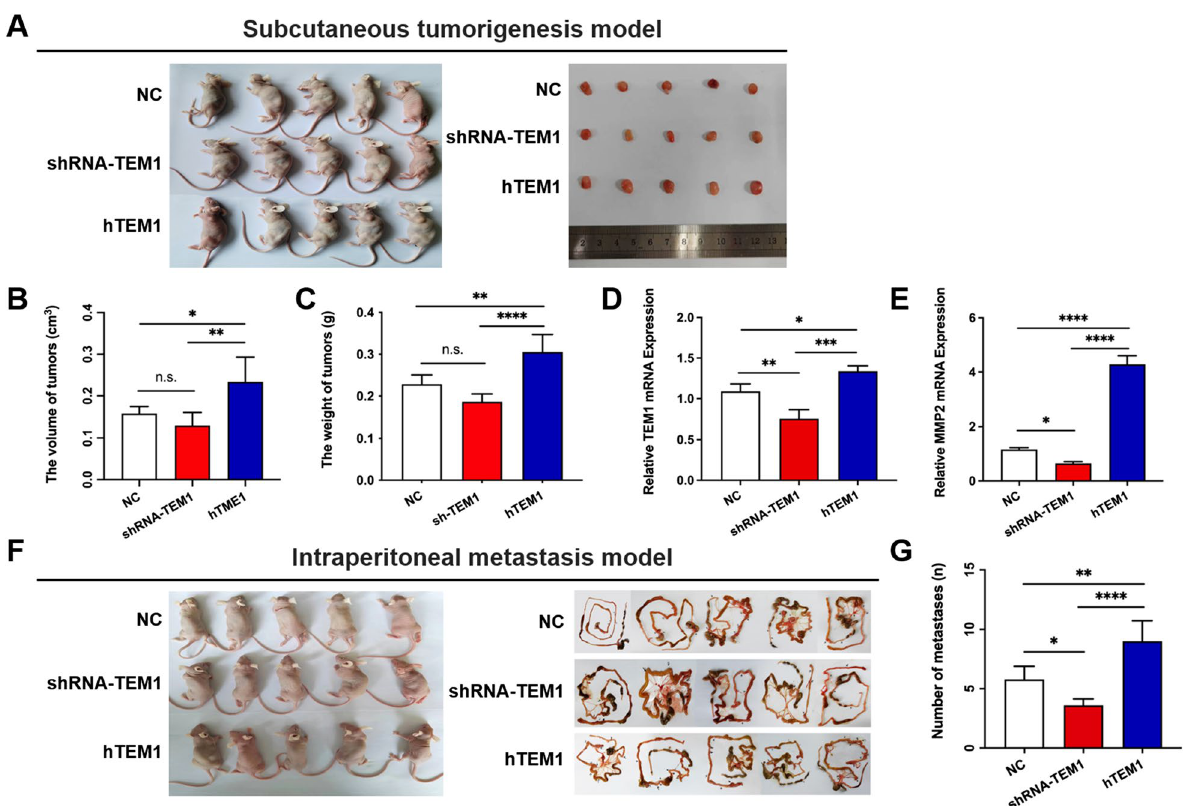
Fig. 7 TEM1 promotes the metastasis of uterine sarcoma cells rather than tumor growth. A MES-SA NC, shTEM1 and hTEM1 cells were injected subcutaneously in three groups of mice respectively (n = 5 in each group). Tumor weight B and volume C were measured and calcu- lated. TEM1 mRNA D and MMP-2 mRNA E expression levels of subcutaneous tumors from each group were determined by RT-qPCR. F MES- SA NC, shRNA-TEM1 and hTEM1 cells were injected intraperitoneally in three groups of mice respectively (n = 5 in each group). Metastasis sites were displayed in black arrows and the number of metastases were calculated G . n.s., none-sense; *, P < 0.05; **, P < 0.01; ***, P < 0.001; ****, P <